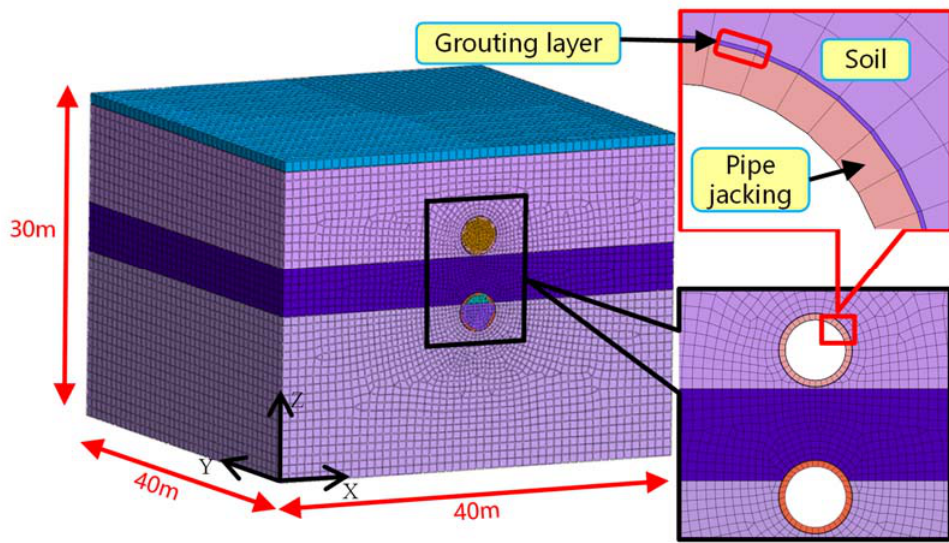
Figure 7. Finite element model.